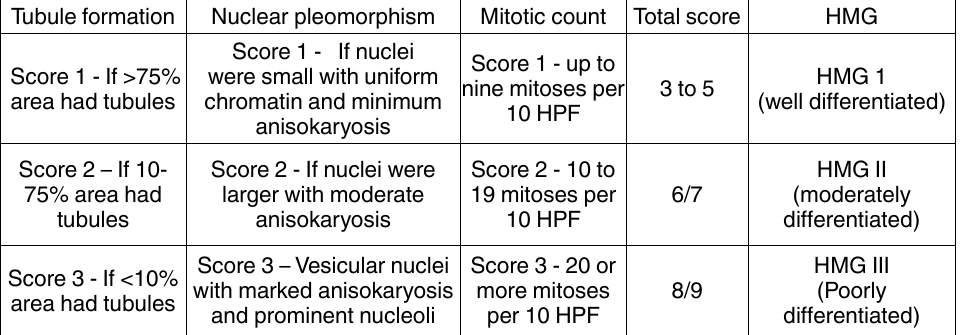
table 1 . HMG grading of tumour Tubule formation Nuclear pleomorphism